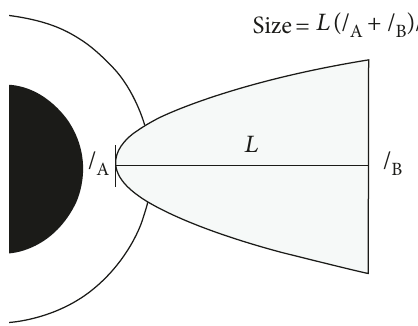
Figure 1: Measuring pterygium dimension method. This method, based on measurements performed by Singh et al. in their study (2015), can be considered crude since the pterygium shape is compared to a